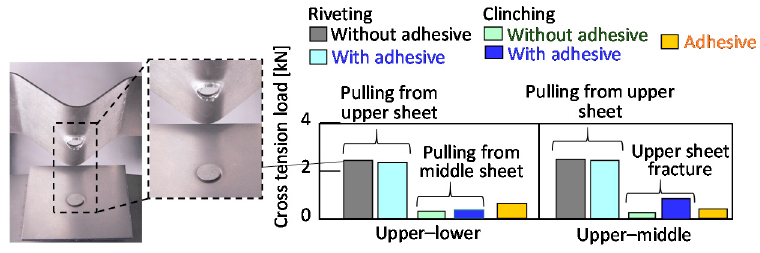
Figure 30. Cross-tension loads of riveted and clinched joints for the upper aluminium alloy sheet.